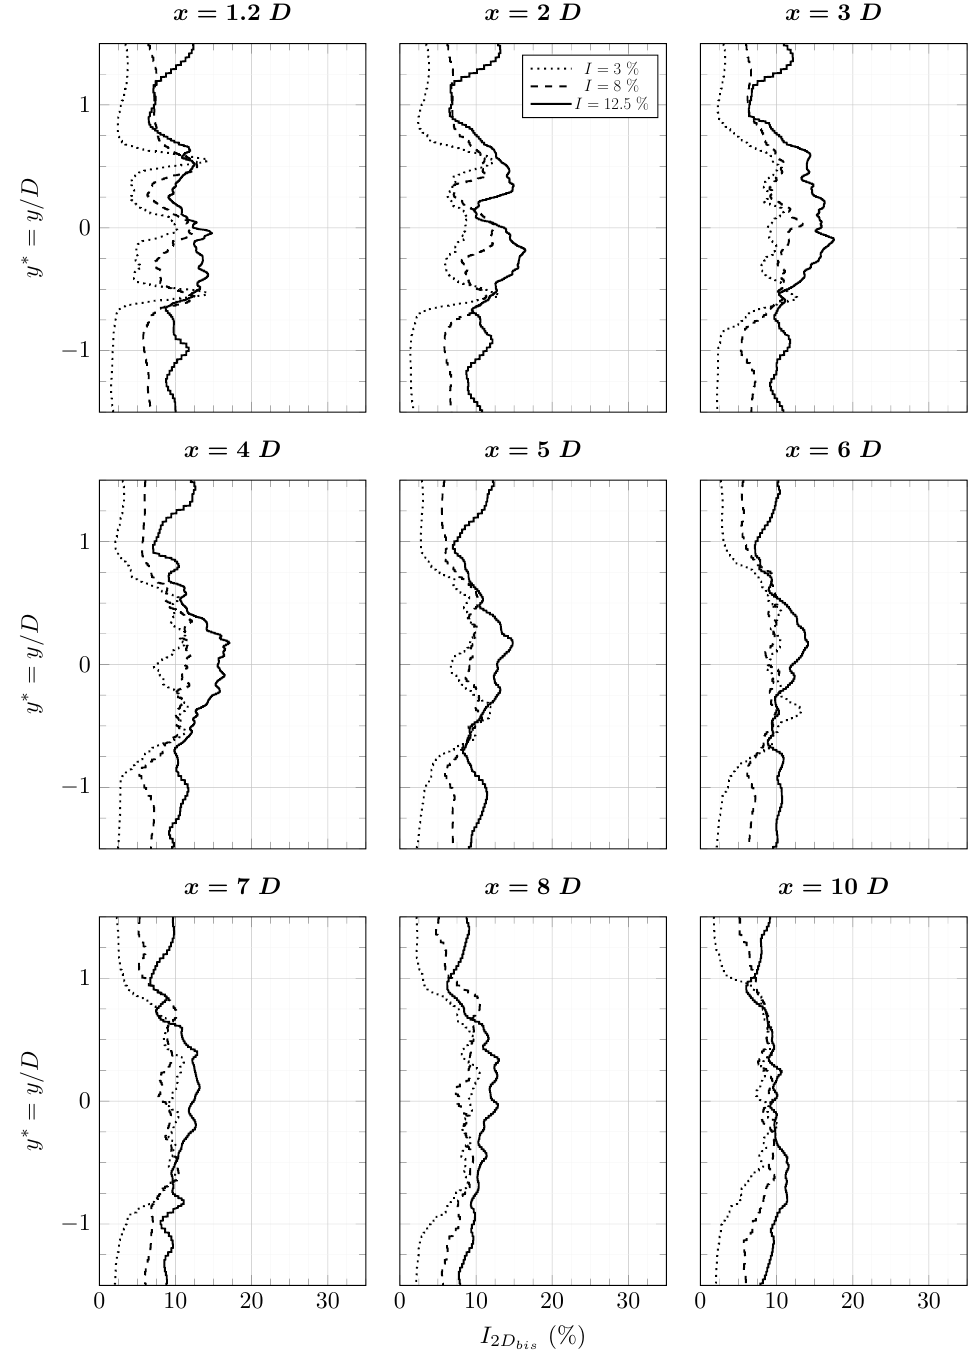
Figure 22. Average axial velocity profiles in the wake of the tidal turbine simulated in LBM-LES at TSR = 3.67 with upstream turbulence intensities of I = [ 3,8,12.5 ]